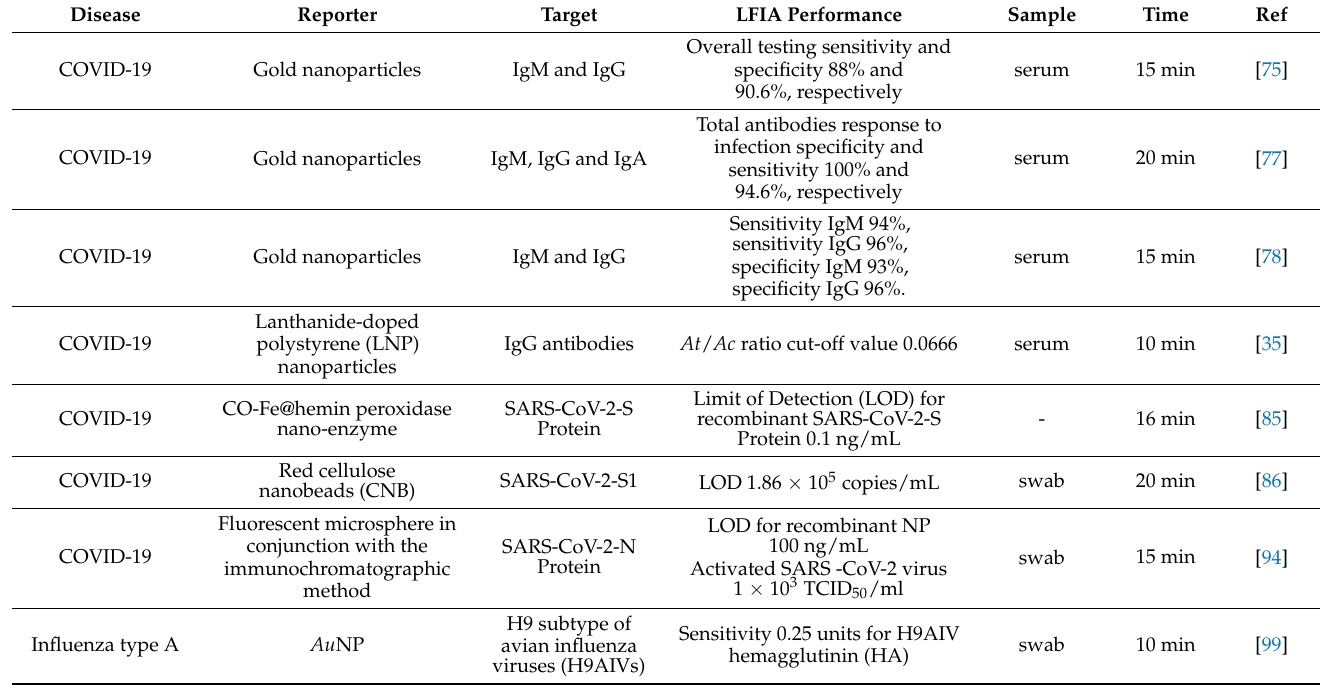
Table 3. List of some of the LFIA based studies for detecting infectious diseases.